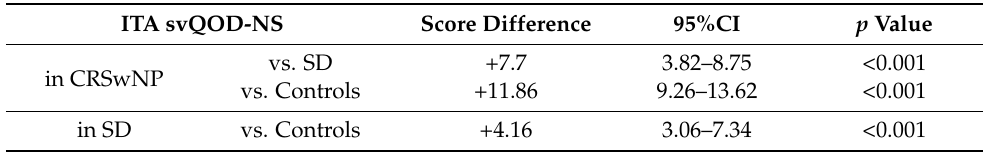
Table 5. Differences of mean total scores of the ITA svQOD-NS in the various subgroups. SD = septal deviation; CI = confidence interval.